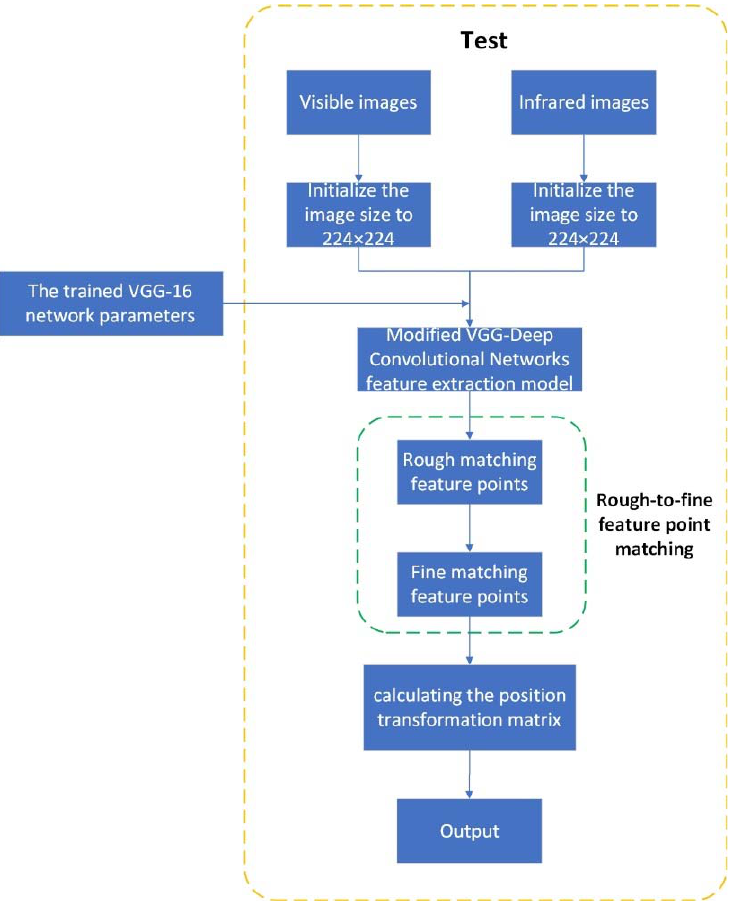
Figure 6. The flow of our algorithm.